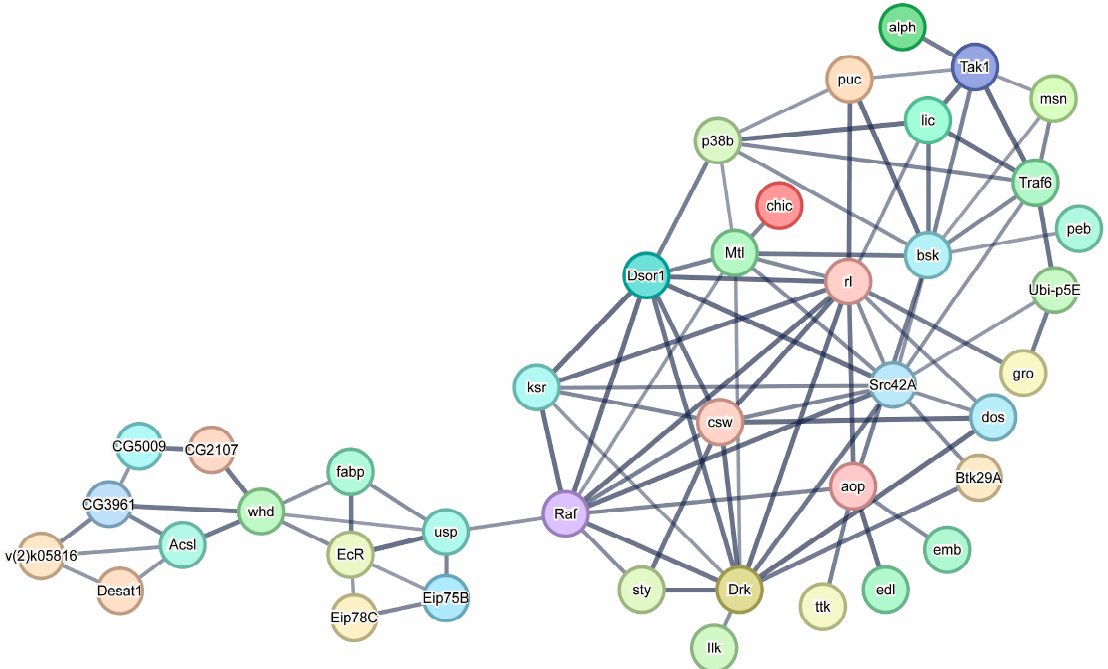
Figure 8. Protein-protein interaction network of MAPK and PPAR signaling pathways. All the in- formation of the proteins in the network are listed in the Supplementary File Table S5.